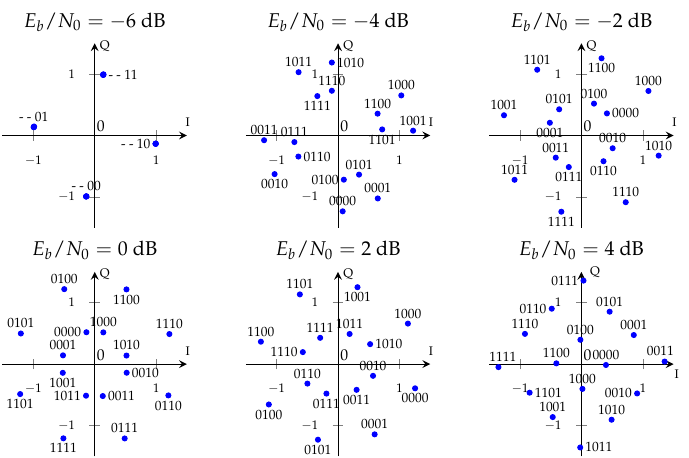
Figure 4. Constellations learned by autoencoder for 4 bits per